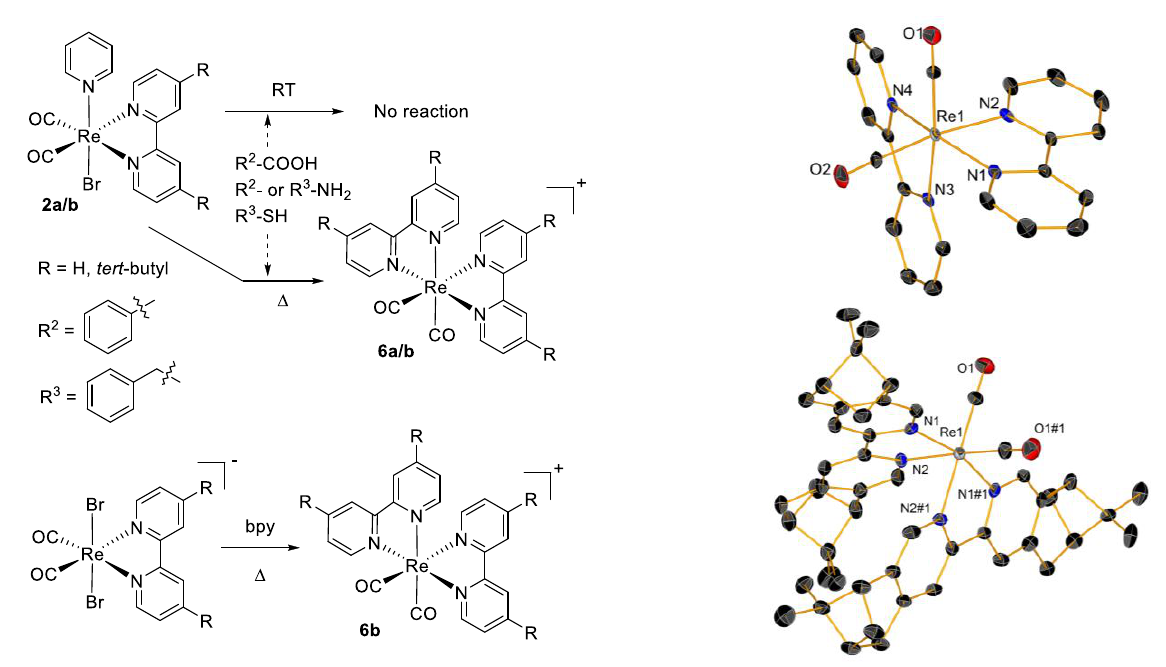
Figure 3. ( Top left ): schemes of the reactions of 2a/b with benzoic acid, aniline, benzylamine and phenylmethanethiol. ( Bottom left ): scheme depicting the general direct synthesis of [Re(CO) 2 (NN) 2 ] + cations (where NN is bpy- or pinbpy-type ligands). ( Right ): ORTEP representations of crystal structures of 6a and 7c cations. Thermal ellipsoids are at 30% probability. Hydrogen atoms are omitted for clarity.